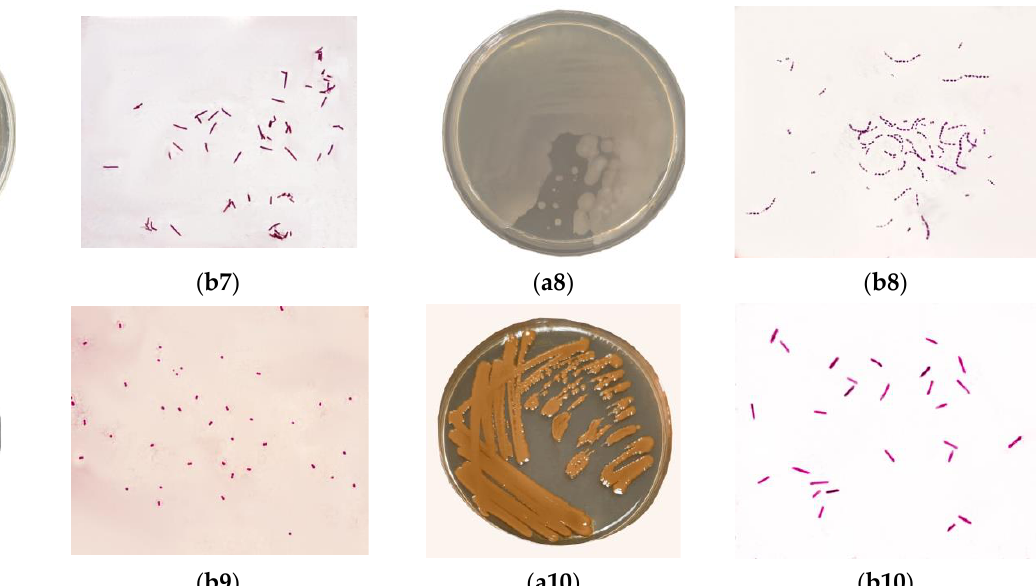
Figure 2. Cultural and morphological properties of isolates: ( a1 – a10 ) — the growth of the studied microorganisms in a Petri dish on the MPA medium, ( b1 – b10 ) — appearance of isolate under a mi- microorganisms in a Petri dish on the MPA medium, ( b1 – b10 )—appearance of isolate under a croscope, ×100. microscope, × 100.